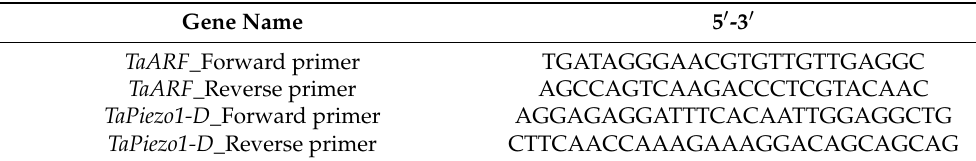
Table 1. List of qRT-PCR